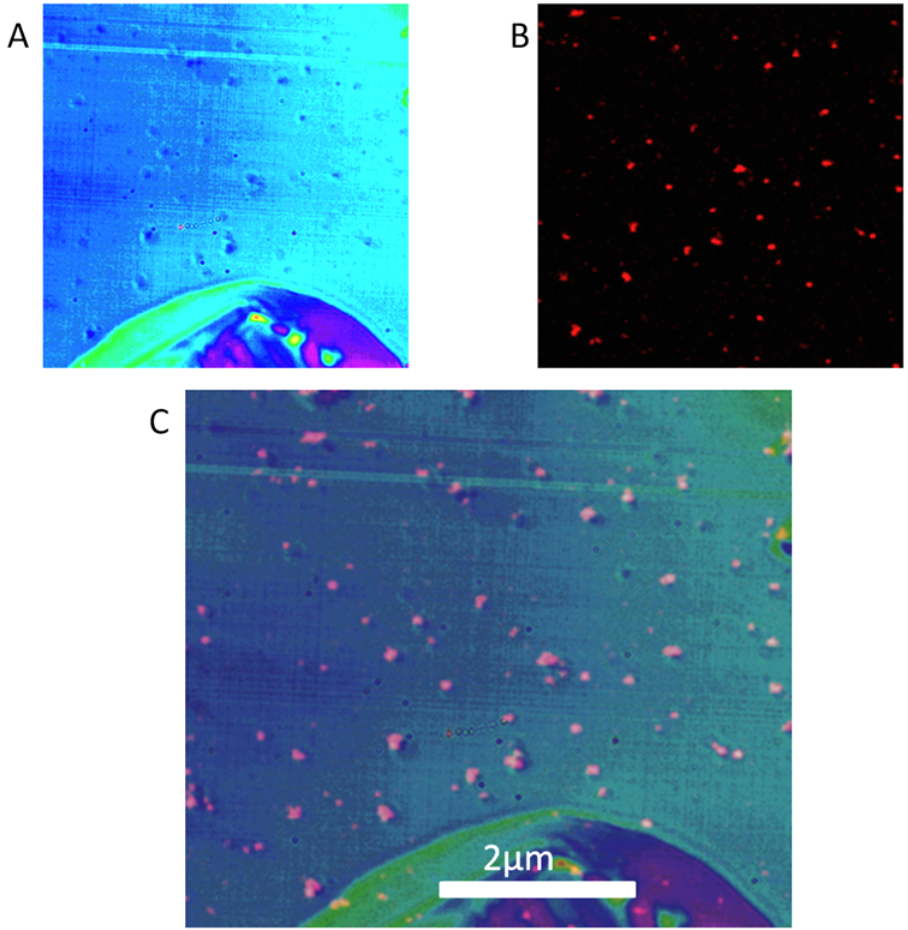
Fig 7. DIC image of AUNPs. (A) DIC image. The large structure on the bottom is an impurity over the glass surface that was used to guide the recognition of the same area for the fluorescence image. (B) Fluorescence image of a small region of the slide with fixed AuNPs excited at 890 nm with emission band pass filter 560 – 650 nm. The image in B is strongly contrasted to make the AuNP visible. A threshold of 20 levels above the background was applied to the fluorescence image to select only the fluorescent AuNPs. (C) Overlay of the DIC and fluorescence image. All particles in B have a corresponding DIC signal in A, but not all dots in A have a corresponding fluorescence dot in